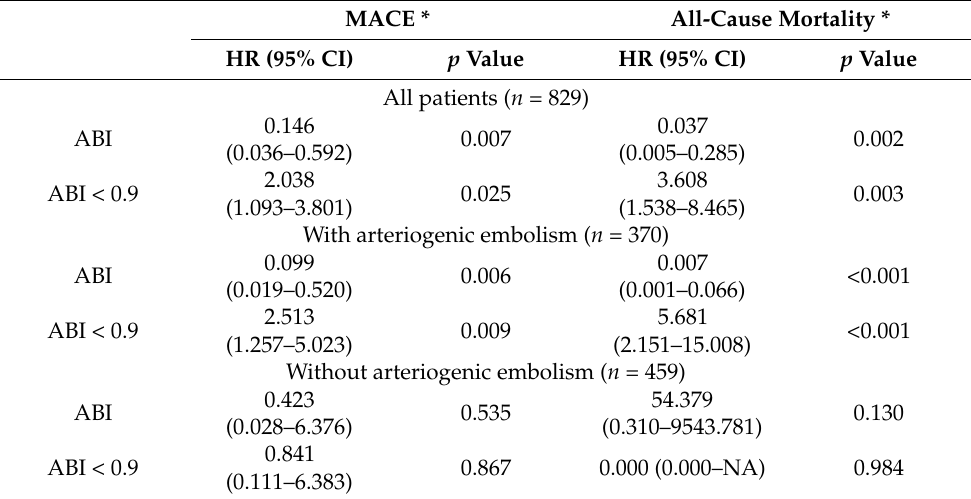
Table 2. Multivariable Cox regression analysis of long-term outcomes as per the presence of arterio- genic